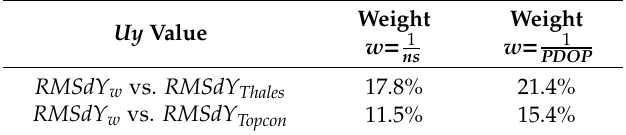
Figure 8. Comparison of RMS errors along the Y-axis. Table 3. The relation between RMS error for the tested methodology along the Y-axis.